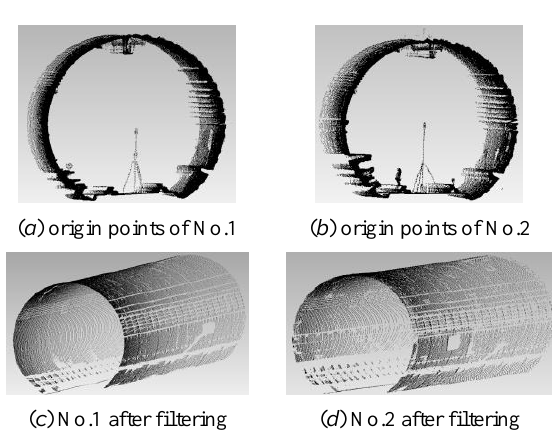
Fig.9 Tunnel Point cloud filtering